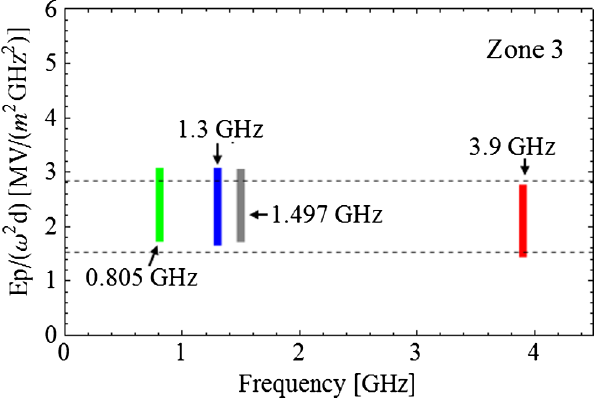
FIG. 15. Frequency scaling of zone 3 MP for scaled TESLA- type cavities.